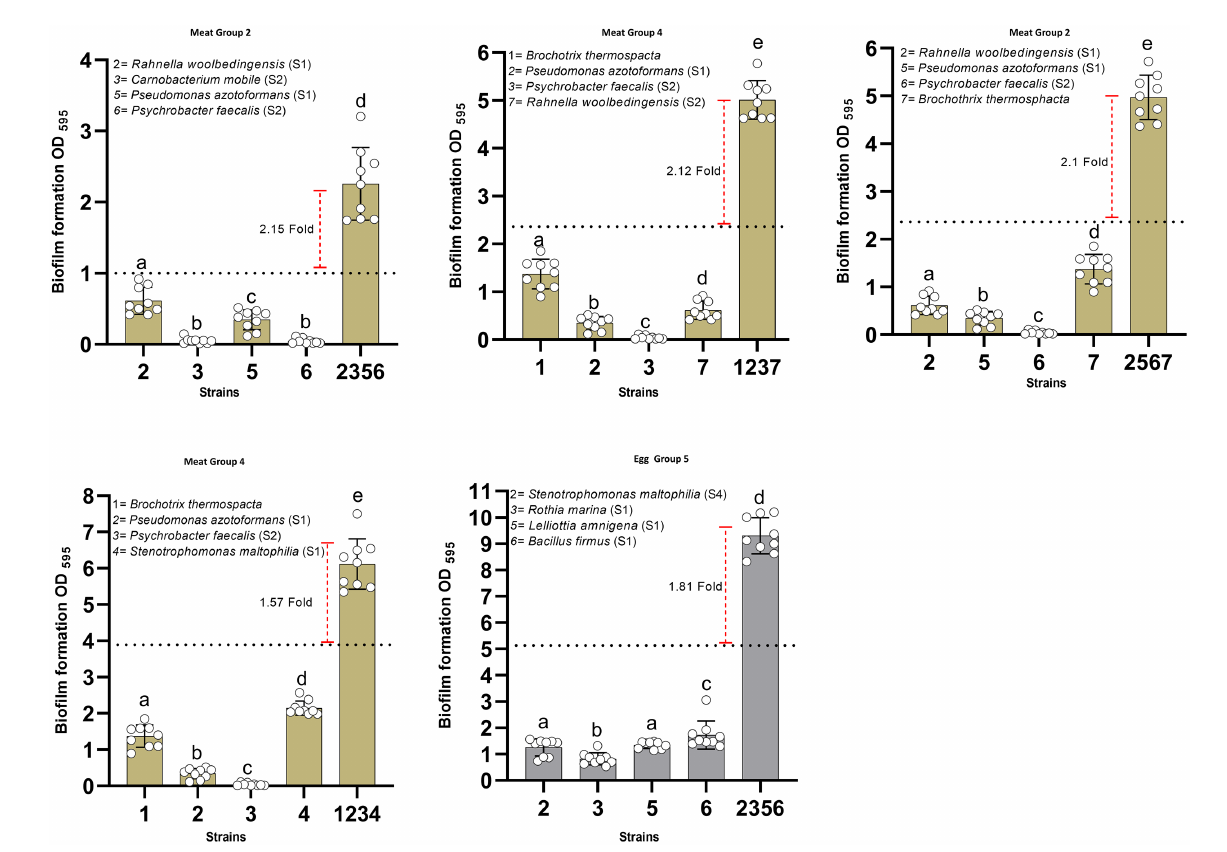
FIGURE 5 Synergistic interactions in four-species biofilm combinations of meat and egg processing strains. All four-species combinations showing pronounced synergistic interactions (at least 1.5-fold increase in biofilm mass compared with sum of biofilm masses of all strains in isolation) are shown. Only one four-species strain combination from food contact surfaces of egg processing industries showed synergy in biofilms (diagram with the gray bars). In each four-species combination, comparisons were made among the biofilm masses of single species and the mixed-species biofilm using one-way ANOVA with Duncan’s post hoc test ( p < 0.05 for